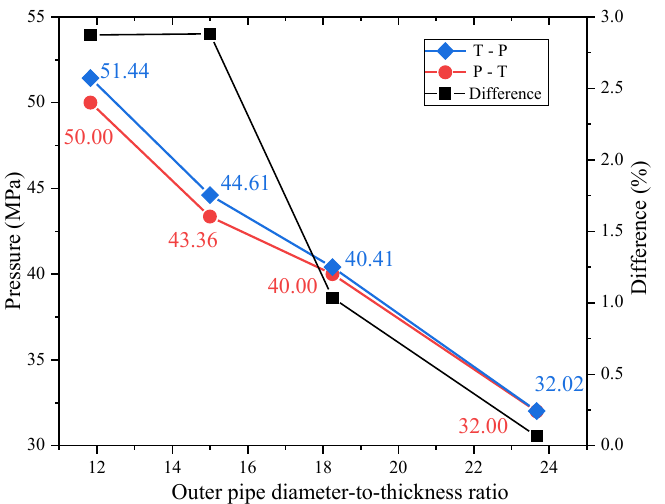
Figure 11. Collapse pressure of sandwich pipe with different outer pipe diameter-to-thickness ratios.